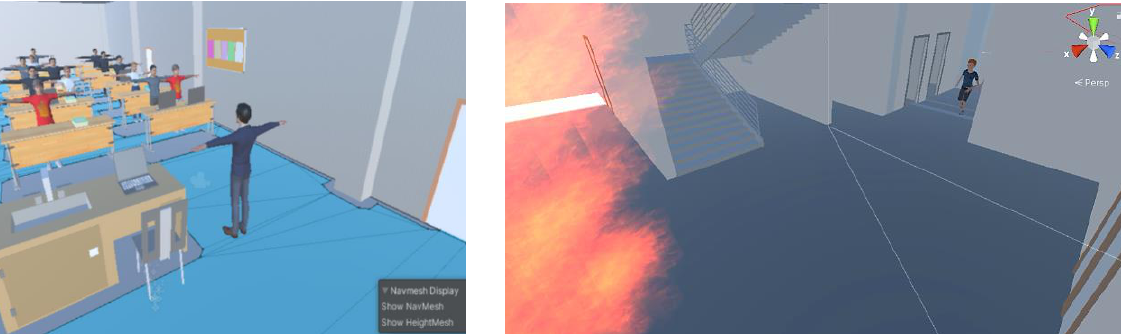
Figure 5 . Simulation environment and the navigation